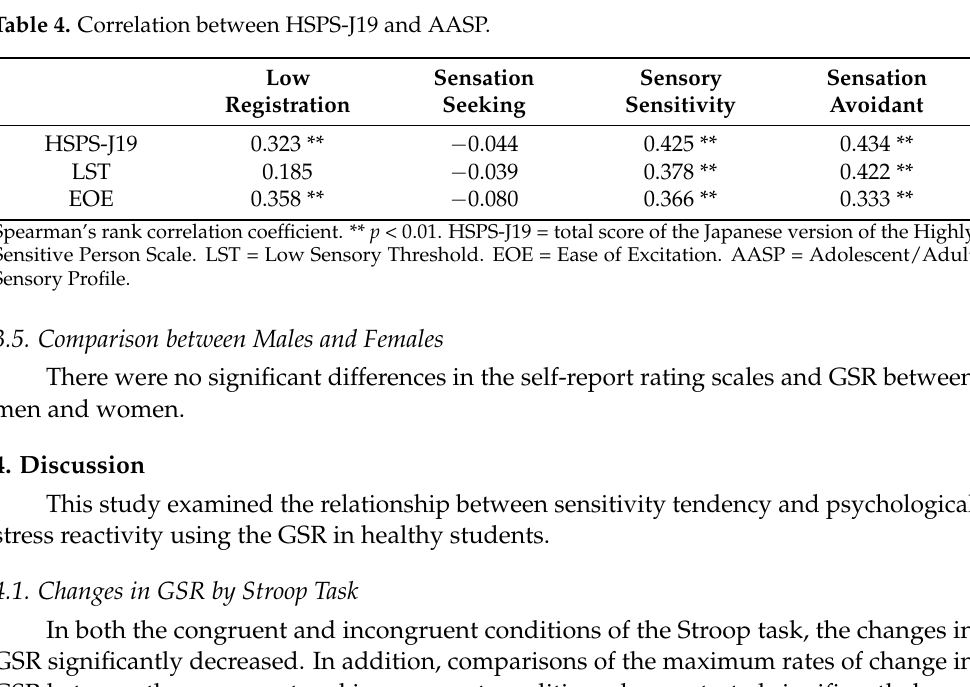
Sensation Seeking